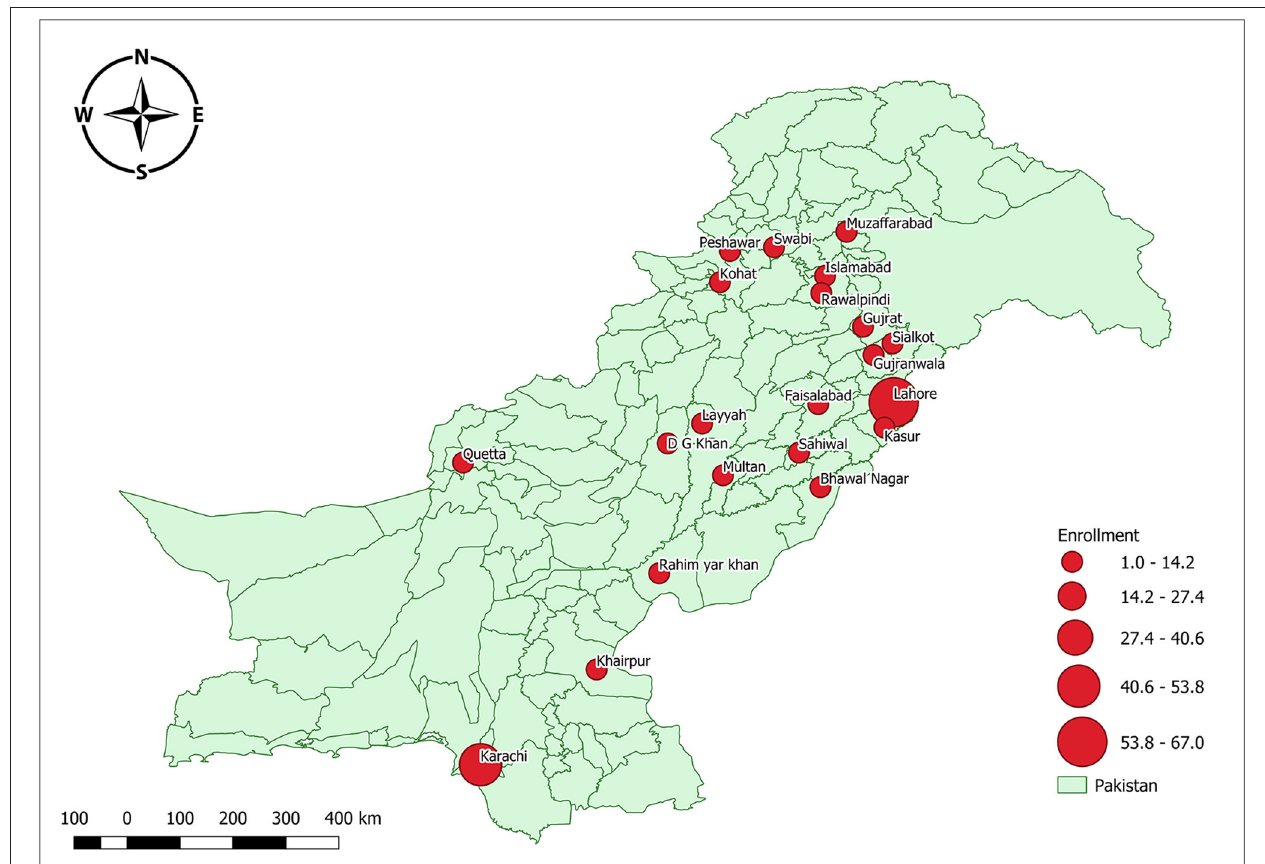
FIGURE 1 | Microbiology massive online open courses (MOOCs) participation from the different parts of the